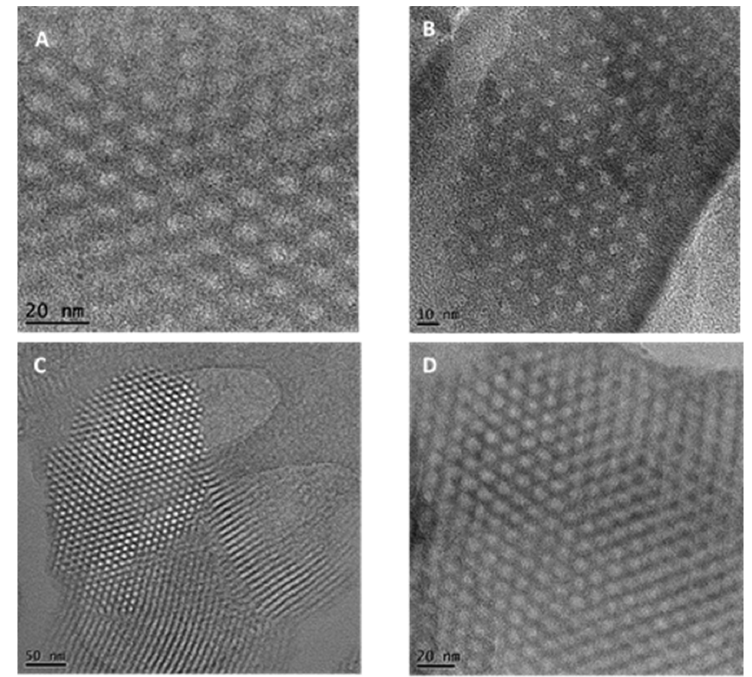
Figure 3. TEM images of SBA ‒ 16 ( above ) and SBA ‒ 15 ( below ) before ( A , C ) and after ( B , D ) EDTA